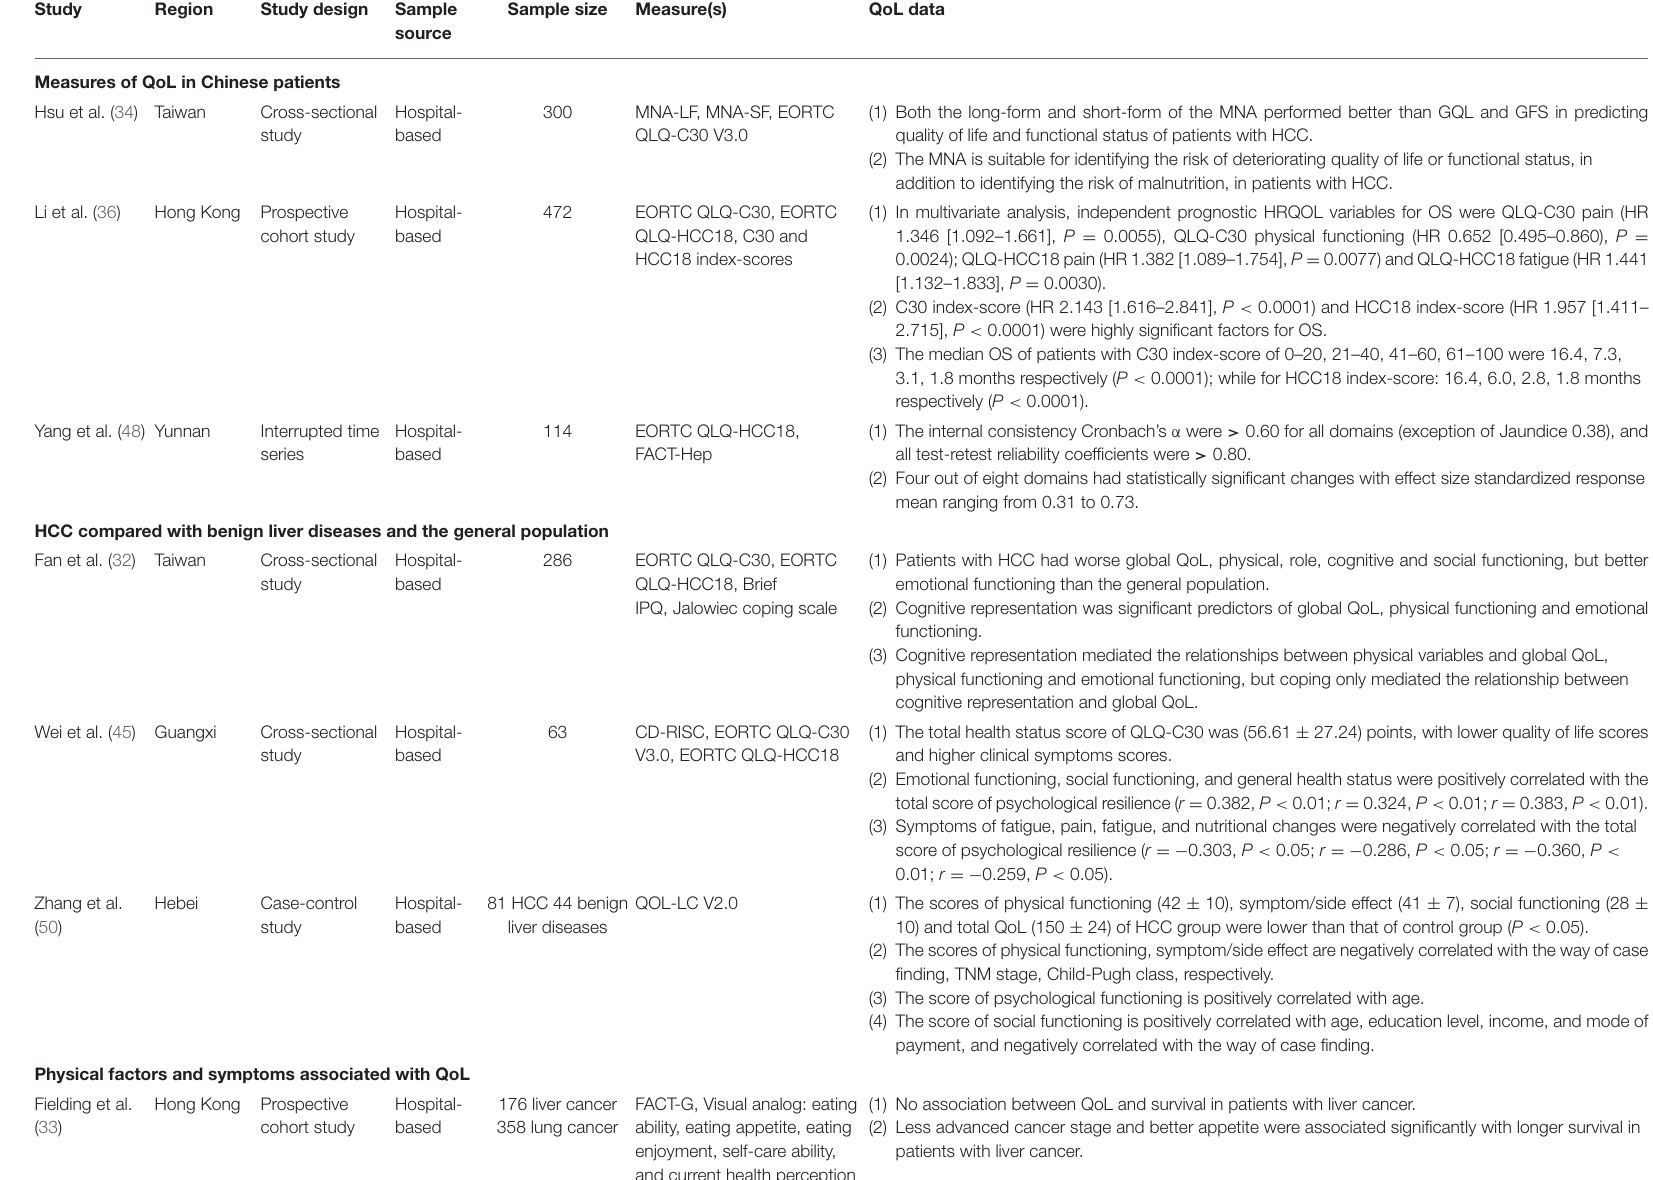
TABLE 4 | Characteristics of selected QoL